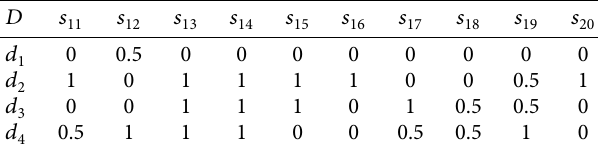
Table 16: Tabular representation of ( G,S ) (Part 2).